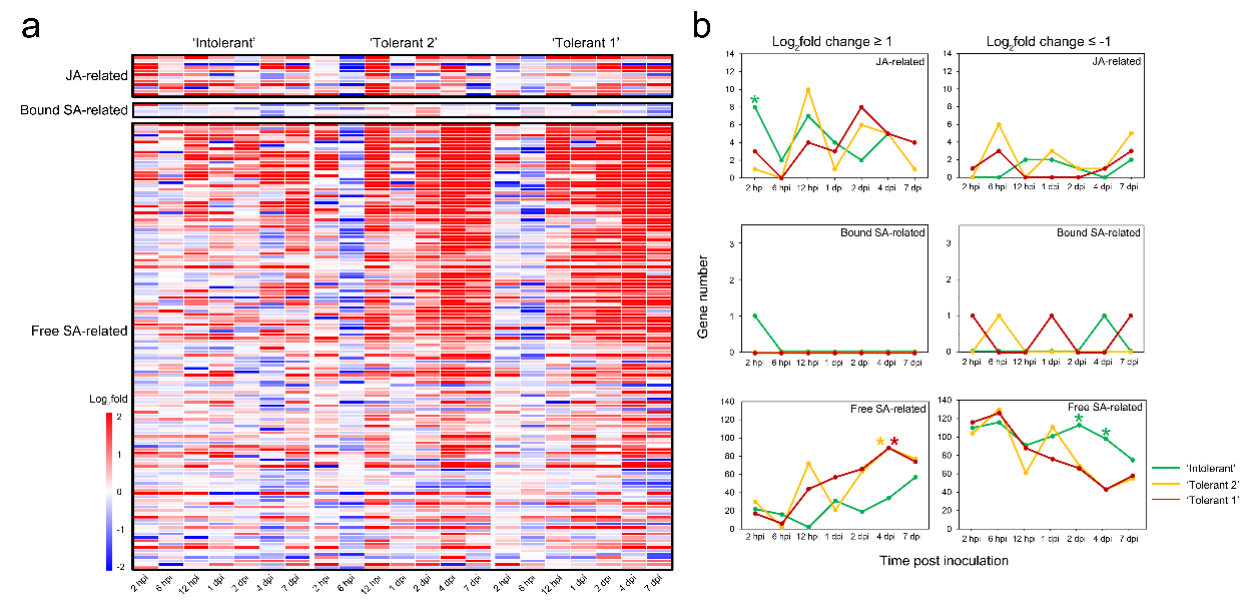
Figure 4. Expression analysis of plant–pathogen interaction-related and signalling-related genes in JA- and SA-related modules. ( a ) Heat map of plant–pathogen interaction-related and signalling-related genes in JA- and SA-related modules. ( b ) Count of differentially expressed plant–pathogen interaction-related and signalling-related genes in JA- and SA-related modules. The * indicates that the gene number is significantly higher.